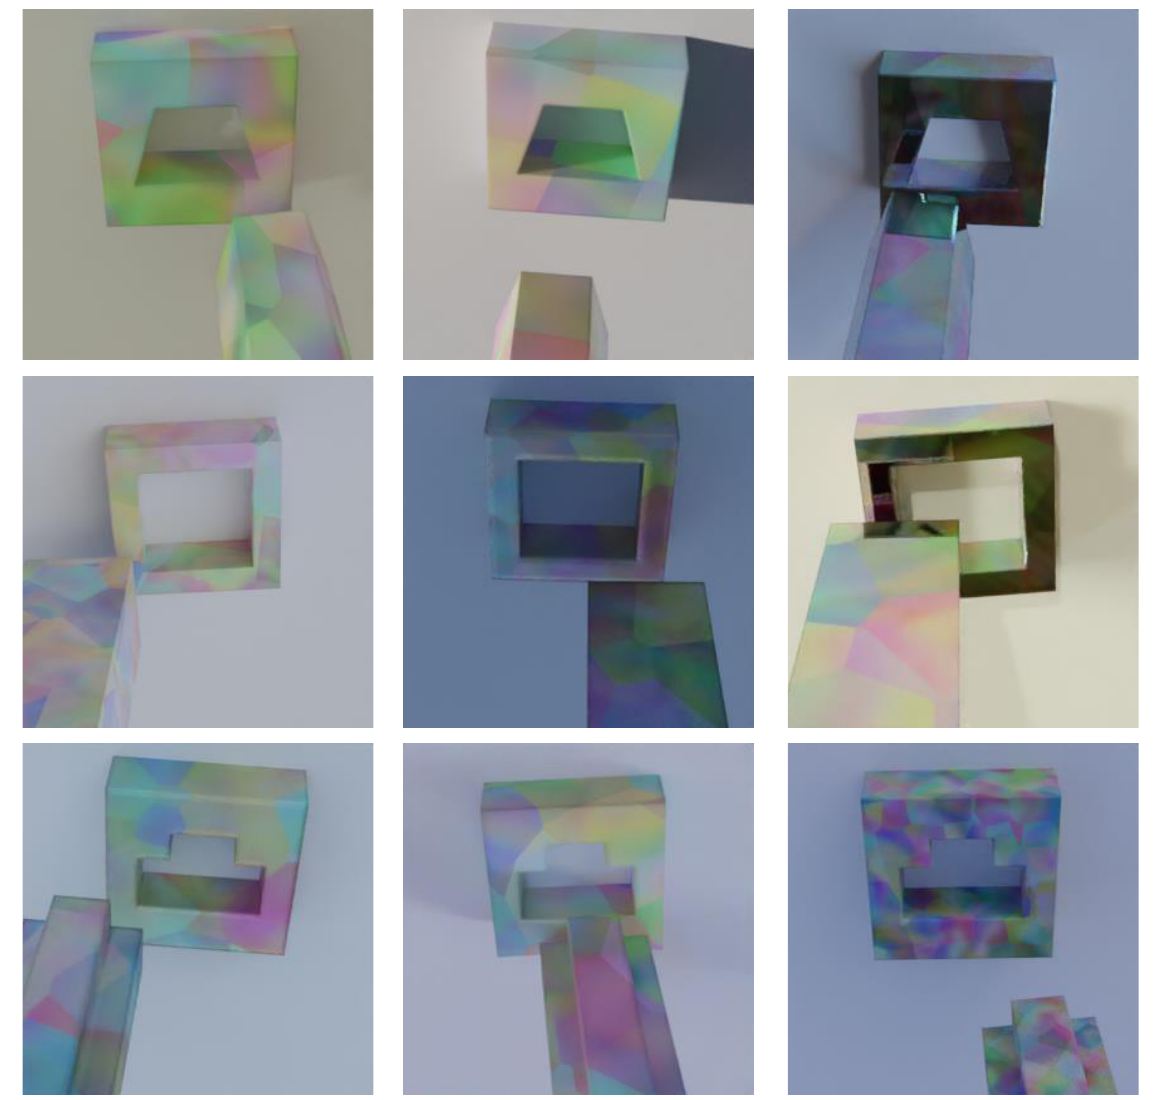
Figure 8. Synthetic data examples for different pegs and holes.